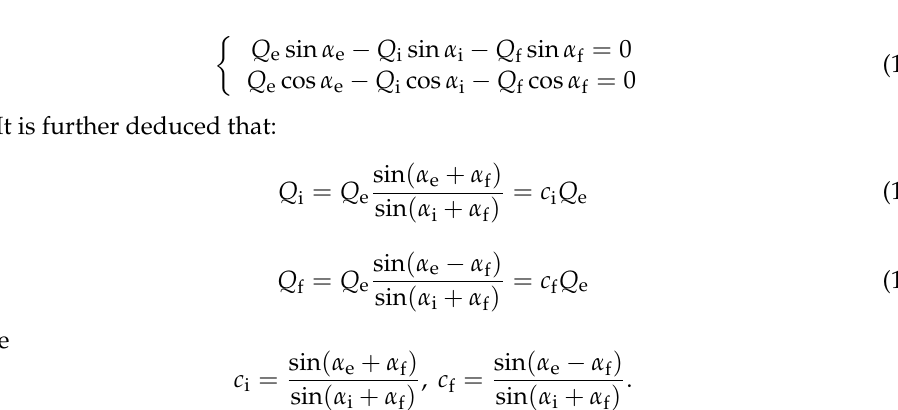
Figure 9. The positions and forces of the tapered rollers. ( a ) The angular positions of the rollers; ( b ) Forces of tapered rollers.